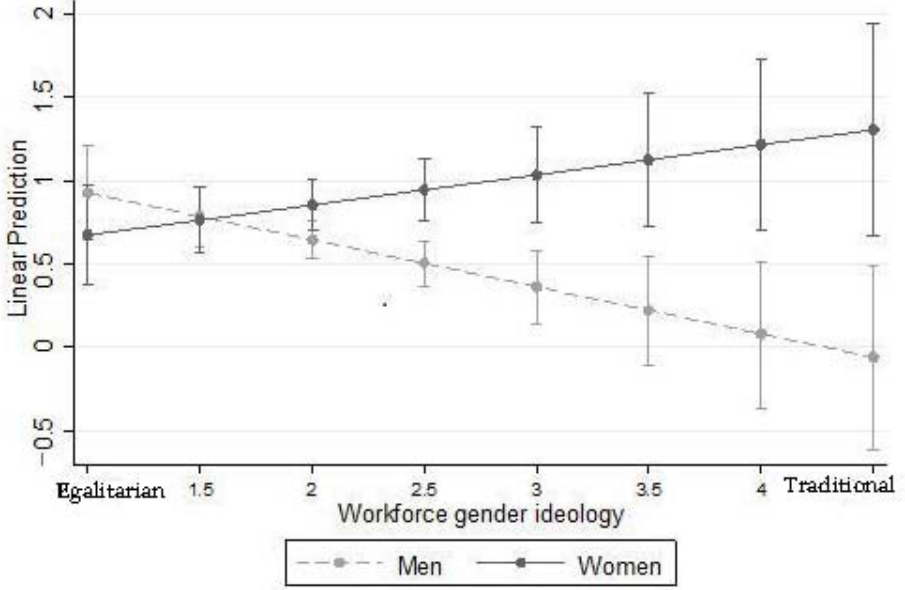
Figure 1. Gender differences in unmet further training expectations and workforce gender ideologies. Note: Results based on Table 4. 95% confidence bands for one ‐ tailed tests. For women, more traditional gender ideologies in the workforce, pre ‐ COVID ‐ 19, were associated with greater unmet expectations than men (b = 0.503, p < 0.05). However,